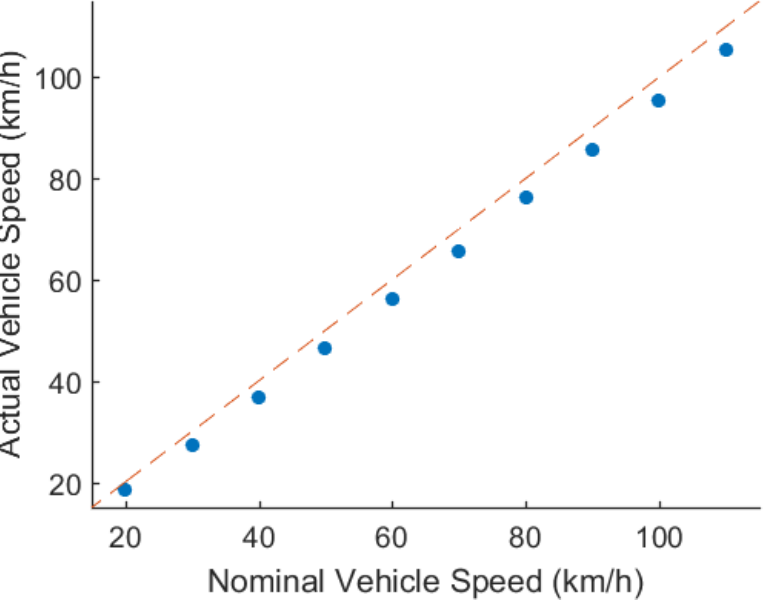
Figure 3. Actual vehicle speed, as measured by a GPS device, against the displayed nominal vehicle speed of a 2016 2.5 (cid:96) Toyota